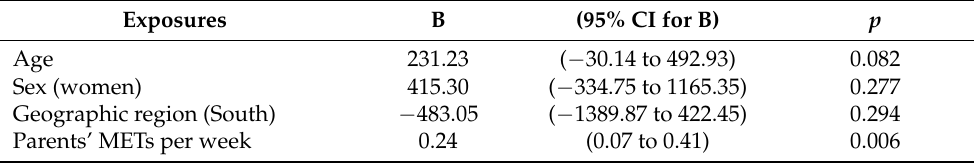
Table 4. Determinants of students’ physical activity at multivariate linear regression *.